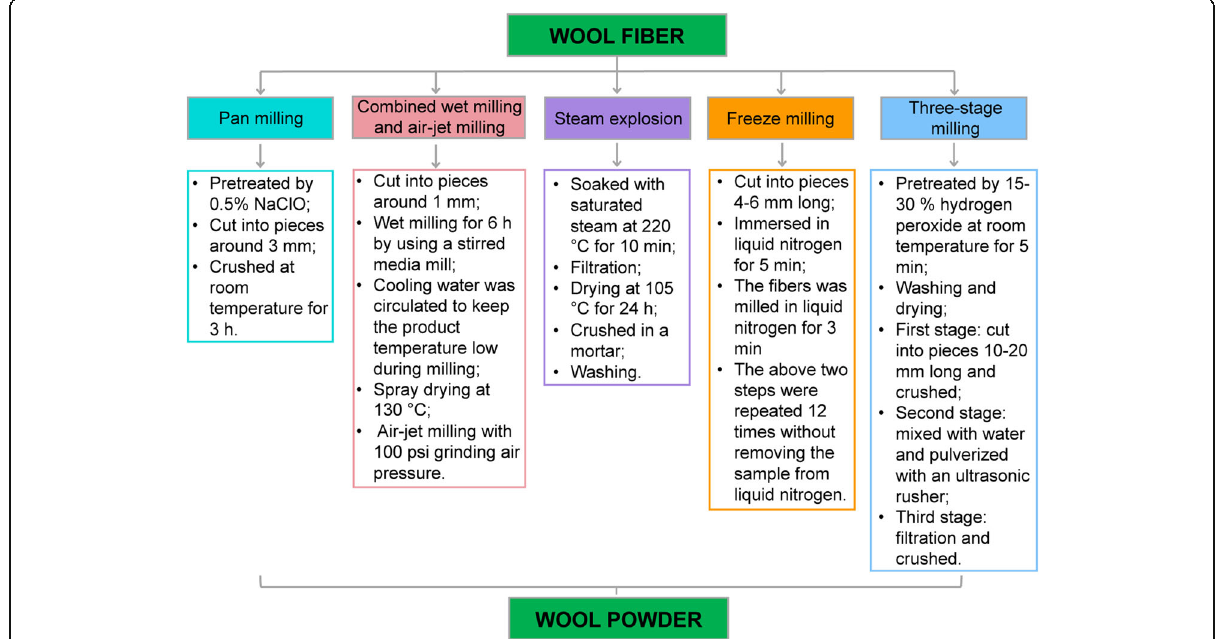
Fig. 1 Mechanical methods of fabricating wool